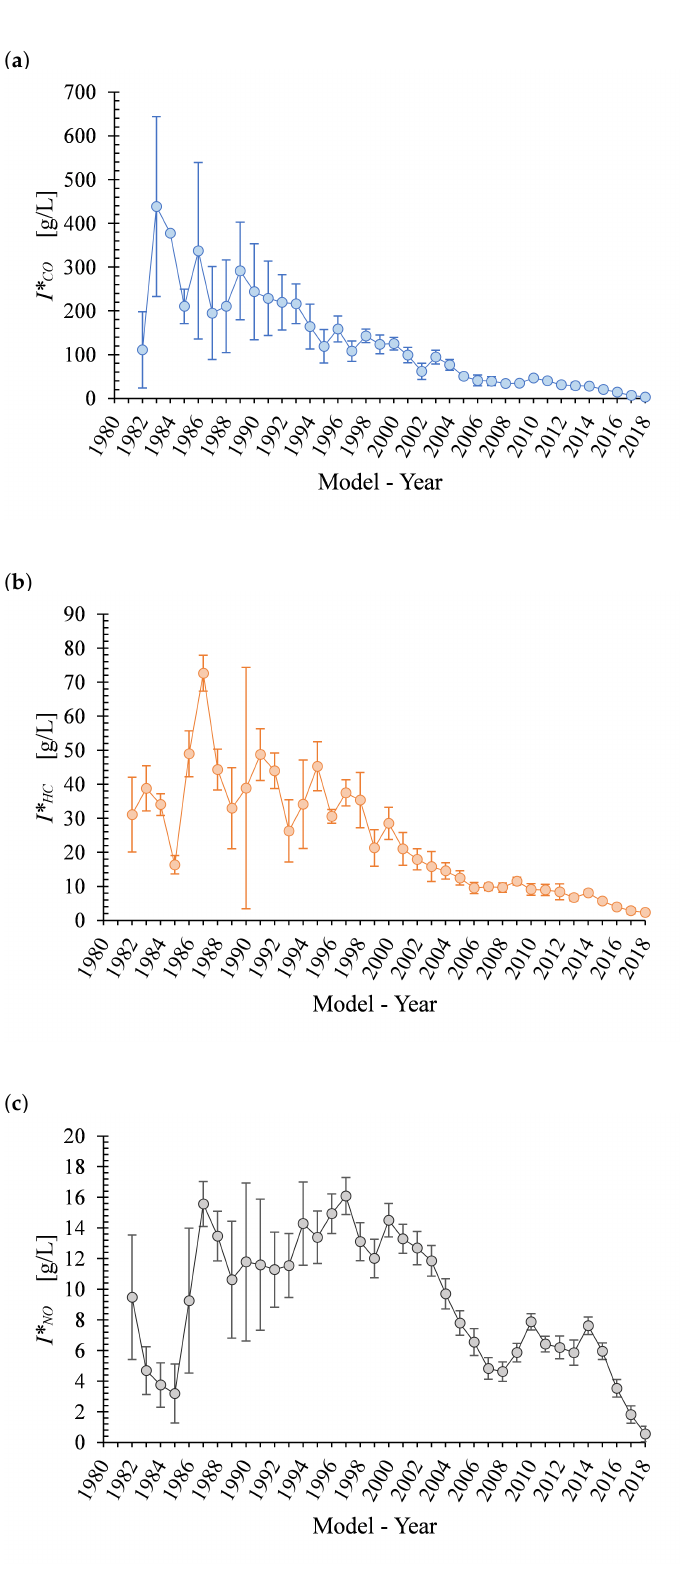
Figure 7. MMA fuel-based emission factors ( I k *) for ( a ) CO, ( b ) HC (propane equivalent), and ( c )